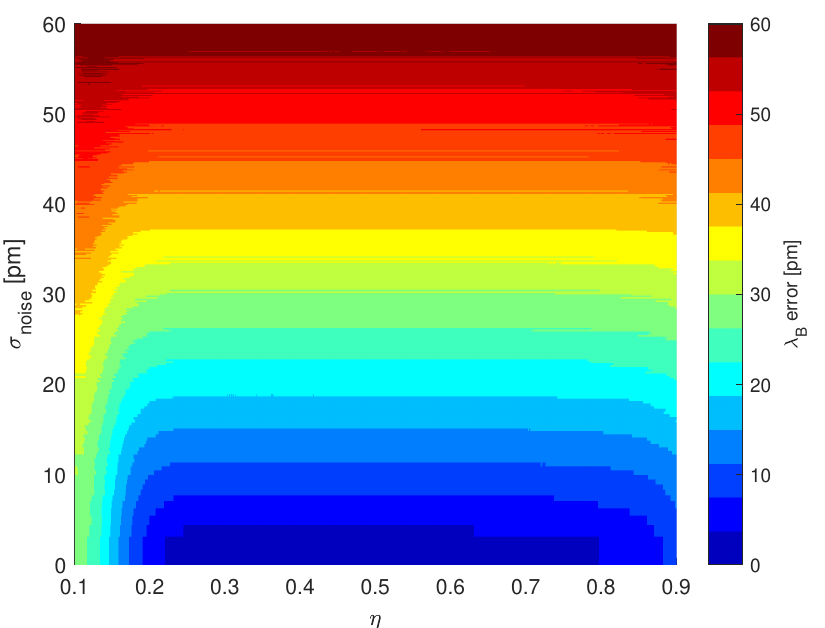
Figure 11. The relation between Bragg wavelength calculation error and laser wavelength instability ( σ 2 ) together with the relative threshold level η utilized in the centroid method. The optimal value of η should be chosen in such a way as to minimize an error. Since the optimal point is related to the noise present in the system, one should properly analyze it before utilizing the centroid method. The simulations were performed in the MATLAB environment. The FBG spectrum was obtained using the TMM approach from [58]. The λ B error is calculated as the difference between the central wavelength obtained from Equation (8) and λ max from Equation (42) in